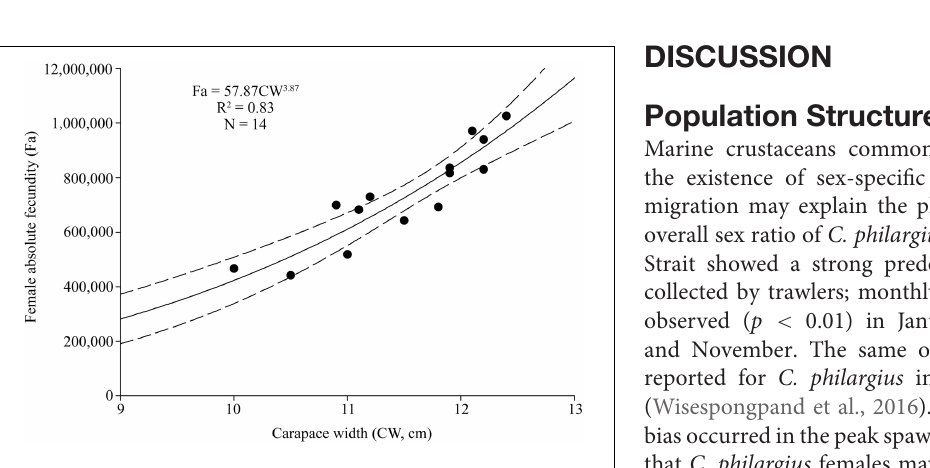
FIGURE 8 | Absolute fecundity ( Fa ) and size (carapace width, CW) relationship for Calappa philargius ( N = 14). Bootstrapped 95% confidence intervals shown with dashed lines ( N =